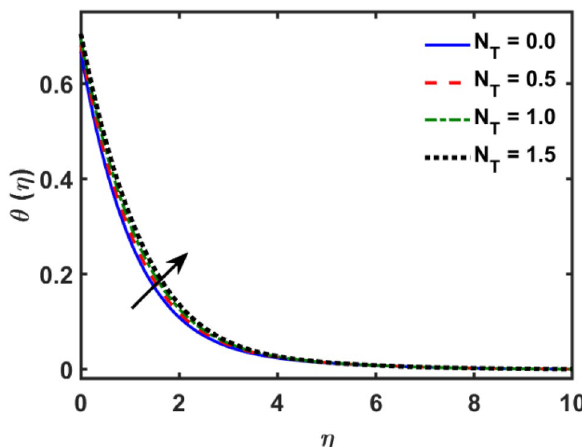
Figure 11. Variation of N T on θ(η) .